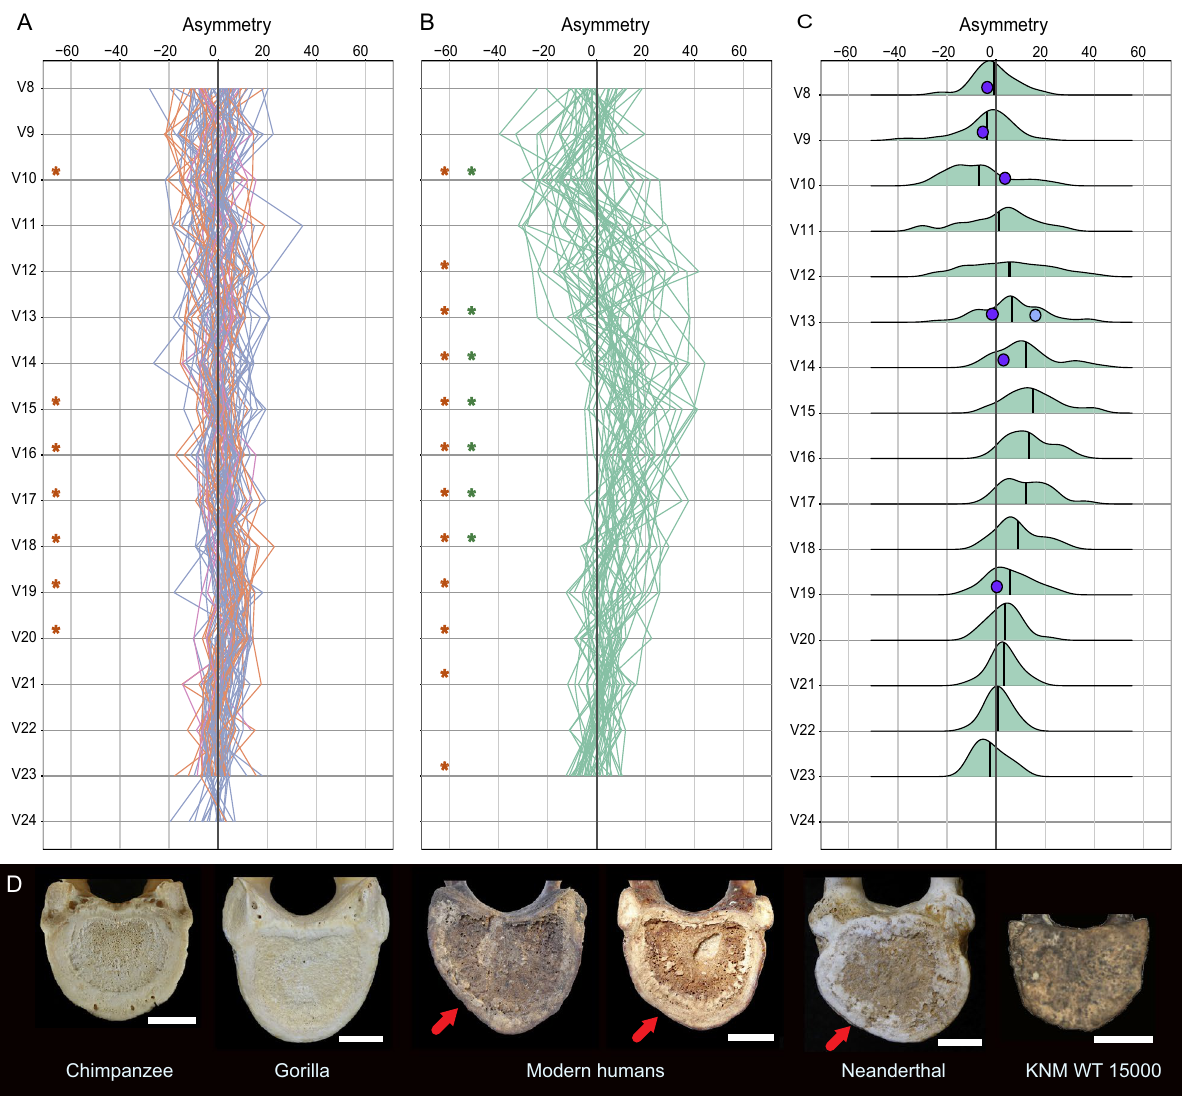
Figure 4. The vertebral body asymmetry values between vertebral levels V8 (T1) and V24 (see Supplementary Material 8). In A, great ape’s values are displayed (73 individuals: Pan , 43; Gorilla , 24; Pongo , 6), following the same color code as in Fig. 1, with orangutan specimens in pink color. In B, human values are displayed (48 individuals). Sexes were combined for great apes and humans. The red asterisk in ( A and B ) indicate vertebral levels where asymmetry was significant, while the green asterisks in ( B ) indicate the vertebral level where the humans were significantly more asymmetric than the great apes. In ( C ), the human density plots per vertebral level are shown, together with the mean value (black vertical line). The value from one Neanderthal from El Sidrón site is shown (light blue circle), as well as the values from the vertebrae from the KNM WT-150000 fossil (dark blue circles). In ( D ), the inferior view of the sixth thoracic vertebral body surface from one chimpanzee, one gorilla, two modern humans, one Neanderthal and the fossil KNM WT 15,000 are shown, with the white bar representing 1 cm. The red arrow in the two modern human vertebra and the Neanderthal vertebra indicates the flattening of the left side of the vertebral body left by the descending aorta, or aortic